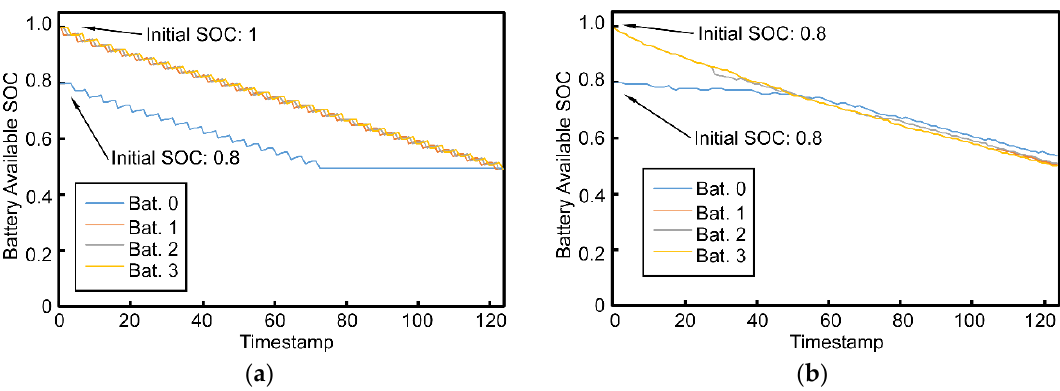
Figure 9. ( a ) SOC curves of the four batteries with imbalanced condition, round-robin scheduling. ( b ) SOC curves of the four batteries with imbalanced condition, RL agent